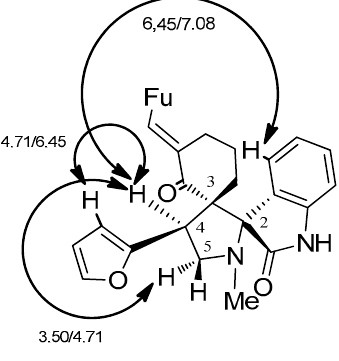
Figure 1. The key NOE contacts for 2g .